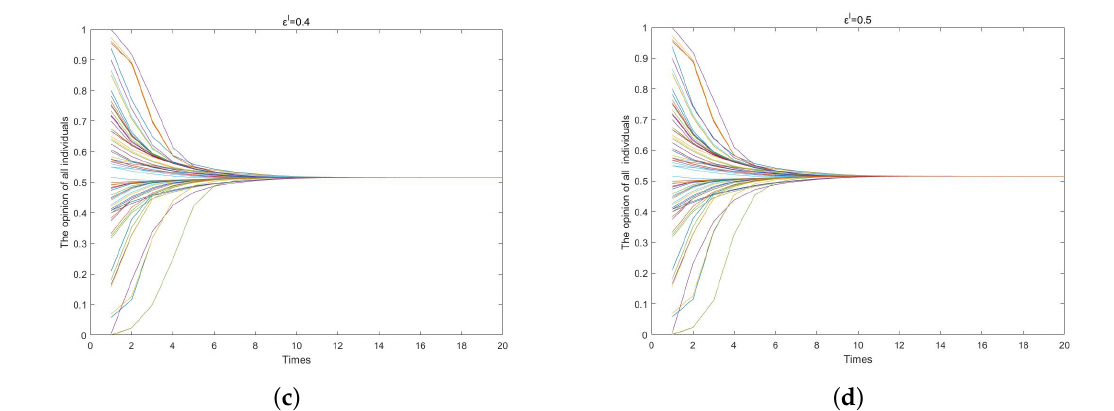
Figure 7. The opinion evolution of all individuals with different confidence levels of the leader.